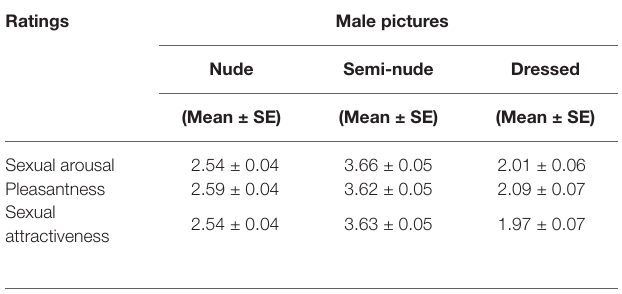
TABLE 1 | Females’ sexual arousal, pleasantness, and sexual attractiveness ratings for male pictures.